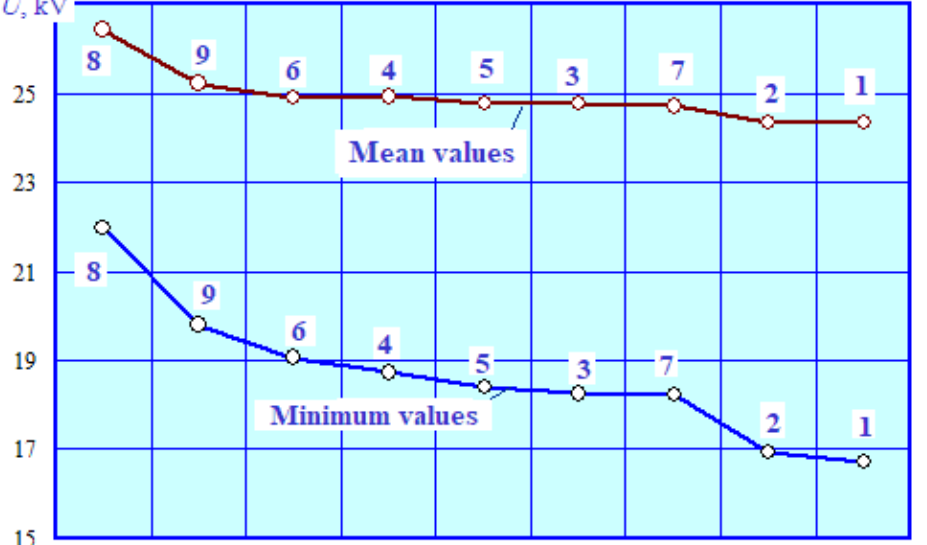
Figure 15. Voltage on the bow collector of the electric locomotive of the first train: 1 is a standard transmission line with AS-600 conductors; 2 is with a vertical arrangement of conductors; 3 represents a coaxial double-segment COHL; 4 is a coaxial four-segment COHL; 5 is a COHL with a delta arrangement of conductors; 6 is double coaxial COHL; 7 is a COHL with a parabolic arrangement of conductors; 8 is a COHL with a three-segment arrangement of conductors; 9 is a COHL with a concentric arrangement of conductors. Table 1. Extreme values of parameters.